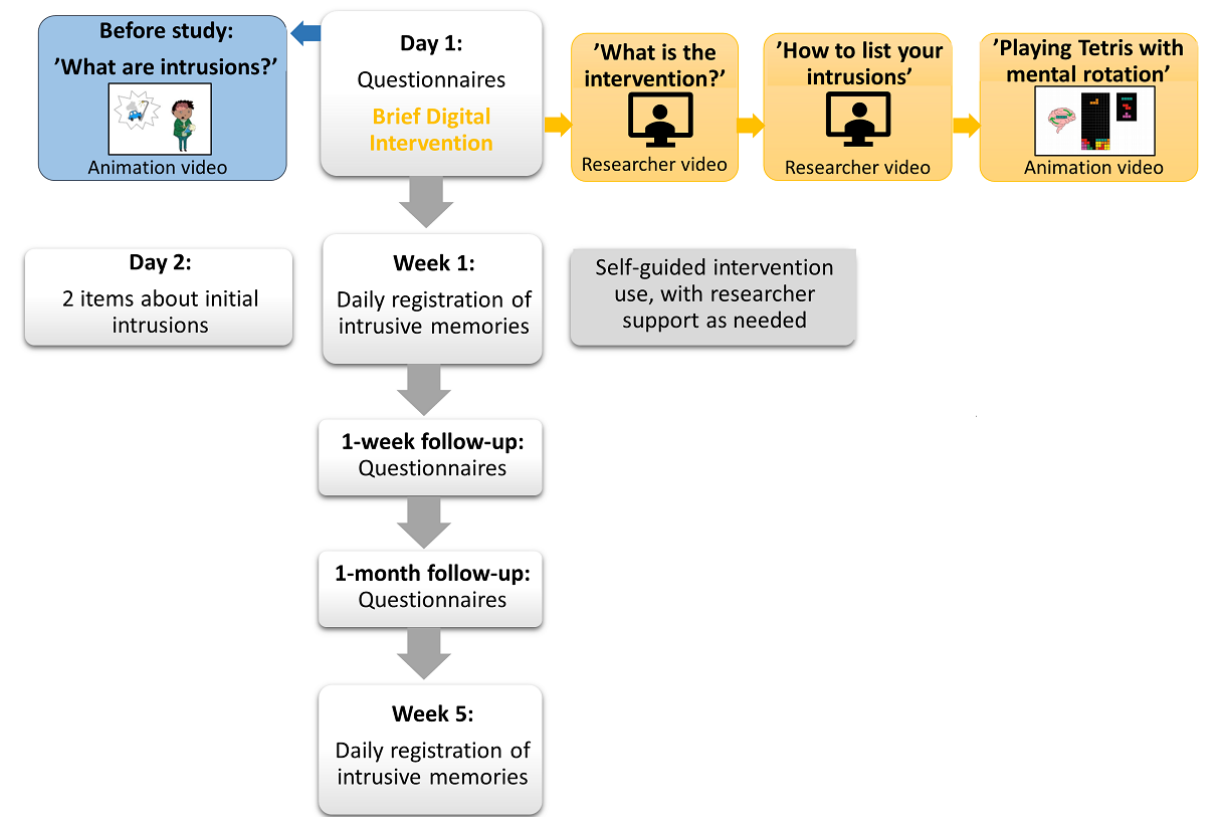
Figure 1. Flow of study procedures. Note that, in contrast to the planned follow-up randomized controlled trial, for these pilot participants, participation ended after the week 5 diary was